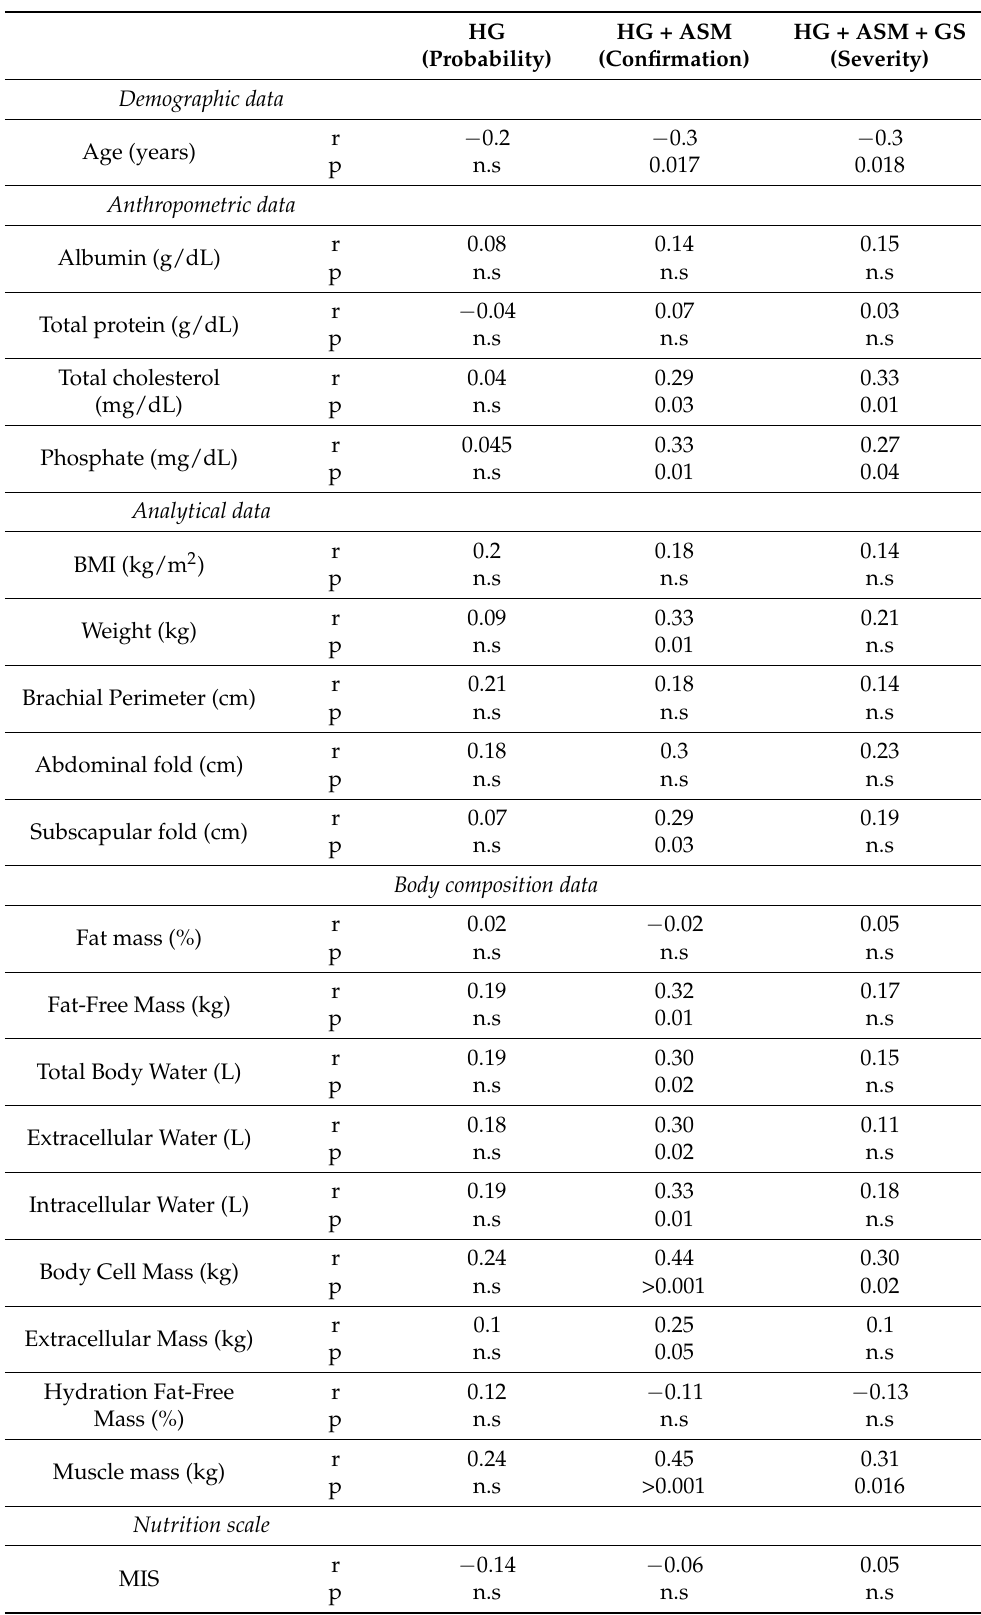
Table 3. Correlation matrix between sarcopenia diagnosis, nutritional and anthropometric parameters and MIS